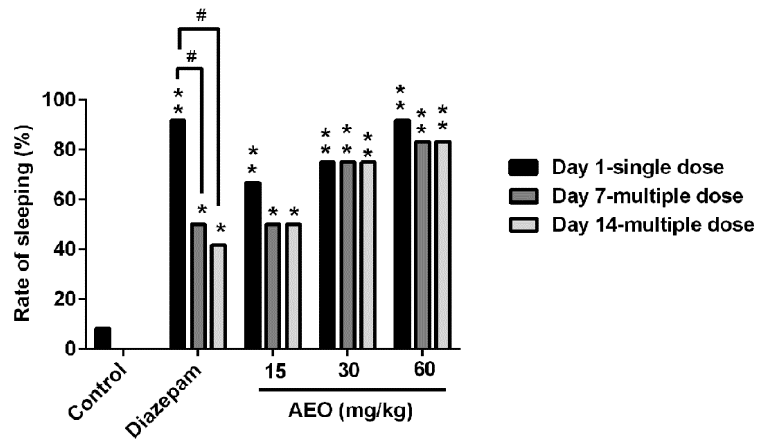
Figure 3. Effect of AEO on subthreshold pentobarbital-induced sleeping. AEO (15, 30, and 60 mg/kg), diazepam (2 mg/kg), or saline was administrated i.p. 30 min before the pentobarbital sodium (25 mg/kg) i.p. injection. The results are presented as mean ± SEM with n = 12. * p < 0.05 and ** p < 0.01 vs. control group at the same time. # p < 0.05 vs. the corresponding group at the same dose.